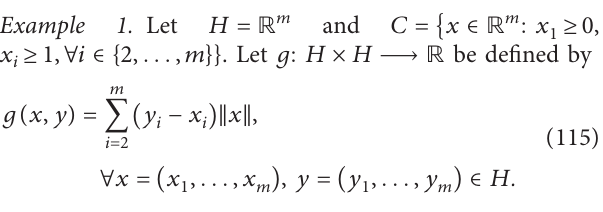
Algorithm 2. The maximum iteration of 100 as the stop criterion is used for Algorithm 1 and 2. The numerical results with the different dimensions m are shown in Figure 1. In this figures, the x -axis represents the number of iterations while the y -axis is for the value of D n generated by Algo- rithm 1 and 2,